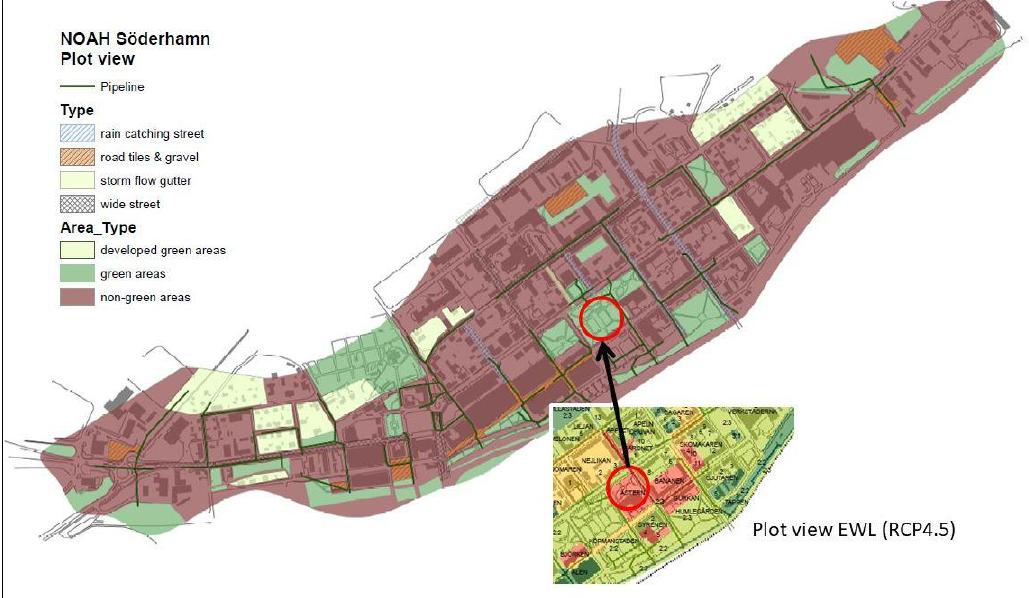
Figure 9. Overlapping EWL with green areas layer to seek for the locations to implement solutions for storm water man- agement.